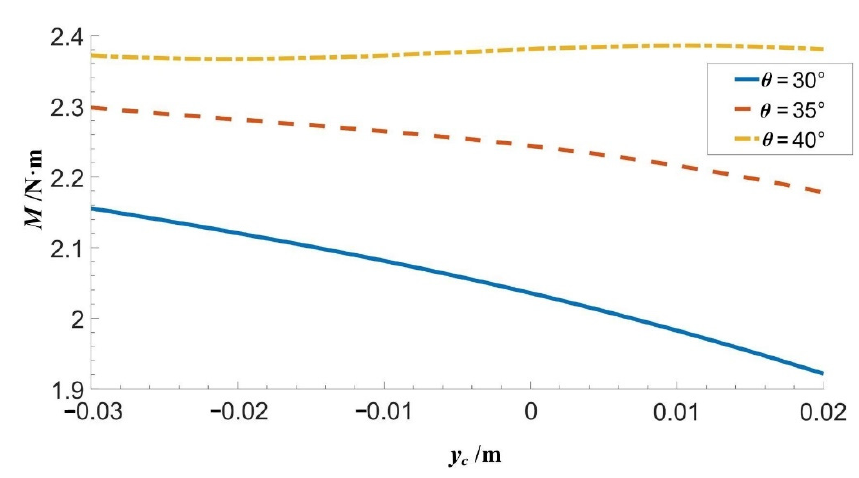
Figure 18. Bending moment M at 30 ◦ , 35 ◦ and 40 ◦ .